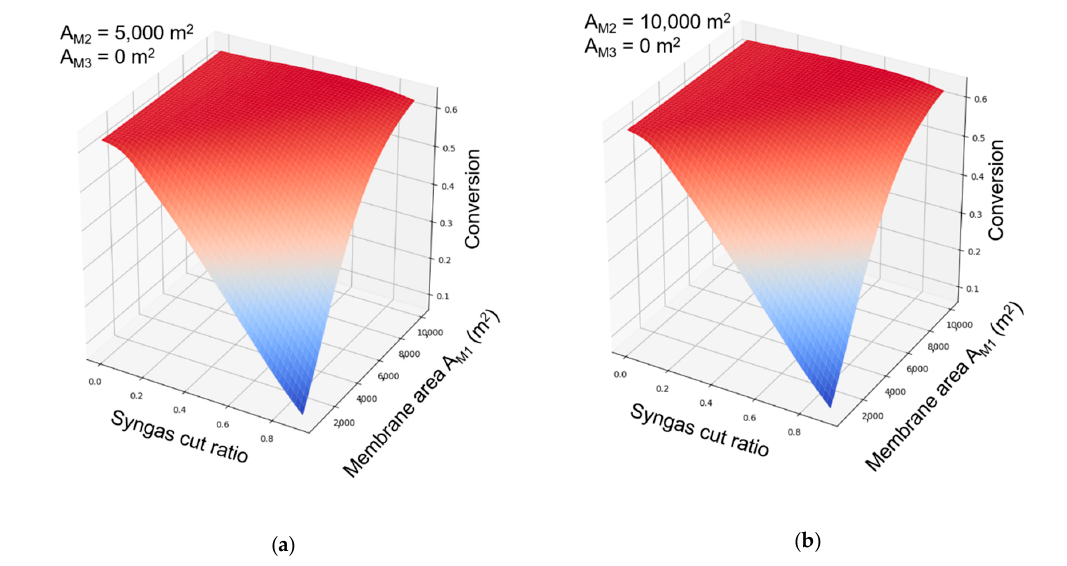
Figure 9. Impacts of membrane area and syngas cut ratio on conversion. ( a ) Area of membrane-202 was 5000 m 2 ; ( b ) area of membrane-202 was 10,000 m 2 .